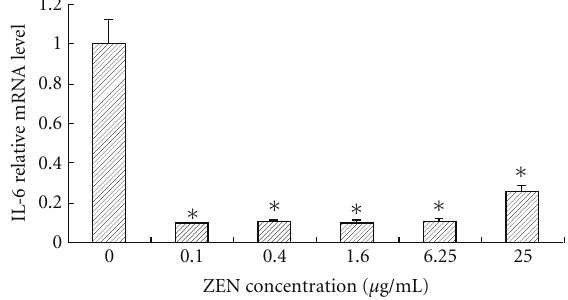
Figure 2: The e ff ect of ZEN on the IL-6 relative mRNA level in ConA-stimulated lymphocytes at toxin concentrations of 0, 0.1, 0.4, 1.6, 6.25, and 25 μ g/mL at 48h. The reporter activity in response to ConA alone is expressed as 100%. Values are the means ± SD from three independent experiments. Statistical analysis was performed using one-way ANOVA followed by Dunnett’s post hoc test ( ∗ P < 0 . 05 versus ConA treated control).